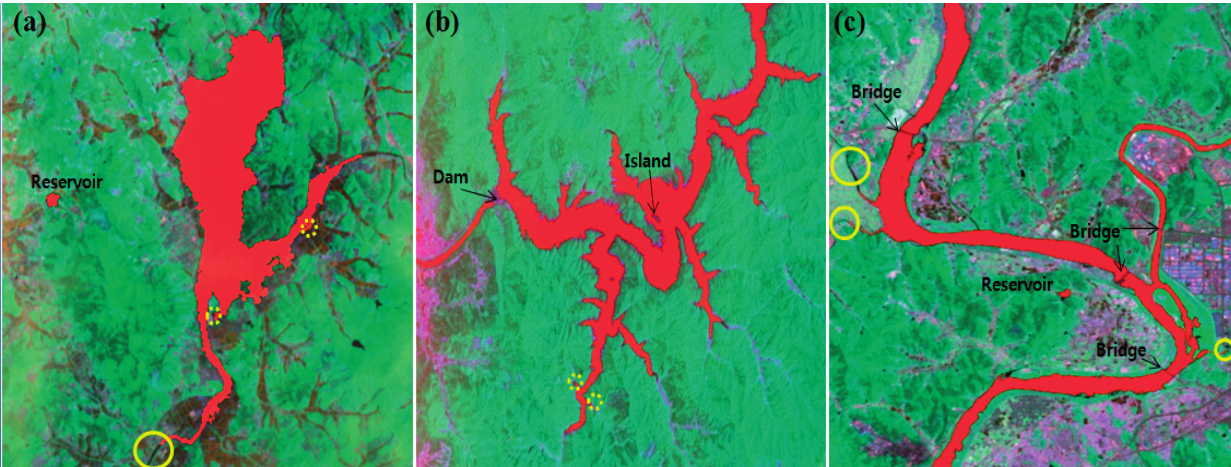
Figure 6. Water body classification results of three test areas, ( a ) Yedang artificial reservoir; ( b ) Soyangho lake; and ( c ) the middle Nakdonggang River of Daegu city. Classified river and lake pixels are marked in red. Miss (solid line) and false (dot line) classifications are marked in yellow